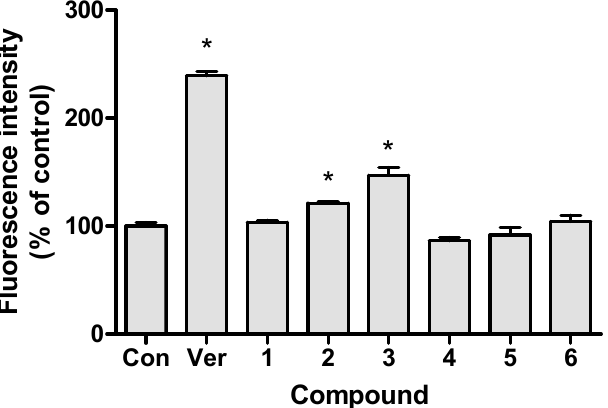
Figure 2. P-gp inhibitory effect of anthraquinones in Caco-2 cells. Cells were treated with 10- μ M anthraquinones or 100- μ M verapamil ( n = 3). Con—vehicle treated control; Ver—verapamil; 1—